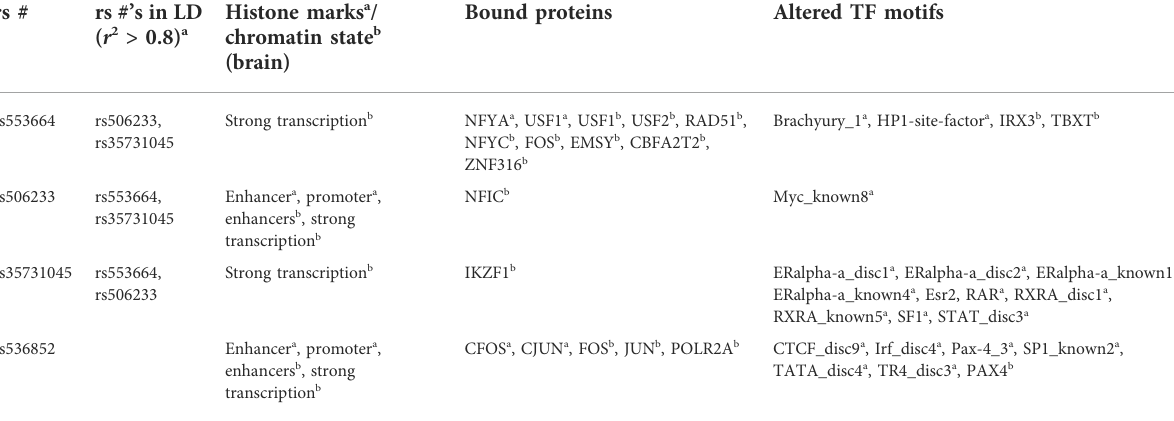
TABLE 5 HaploReg and RegulomeDB annotations.For rs553664 and rs536852, the rs# ’ s in linkage disequilibrium (i.e., r 2 > 80) with the given SNP, the associated histone marks/chromatin state in brain tissues, the bound proteins, and known and discovered altered motifs, are given. rs